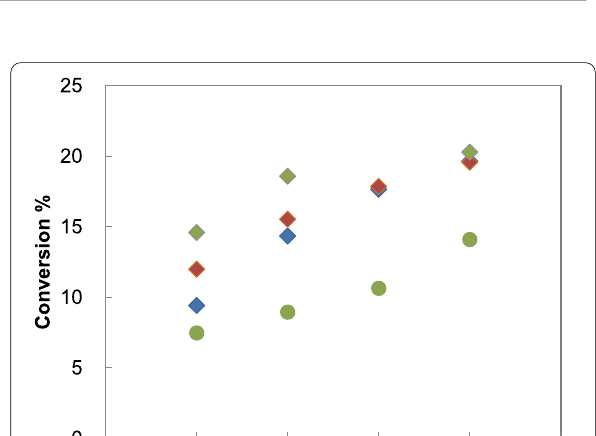
Fig. 5 Hydrolysis reaction of silane coupling agent [18]. B: base